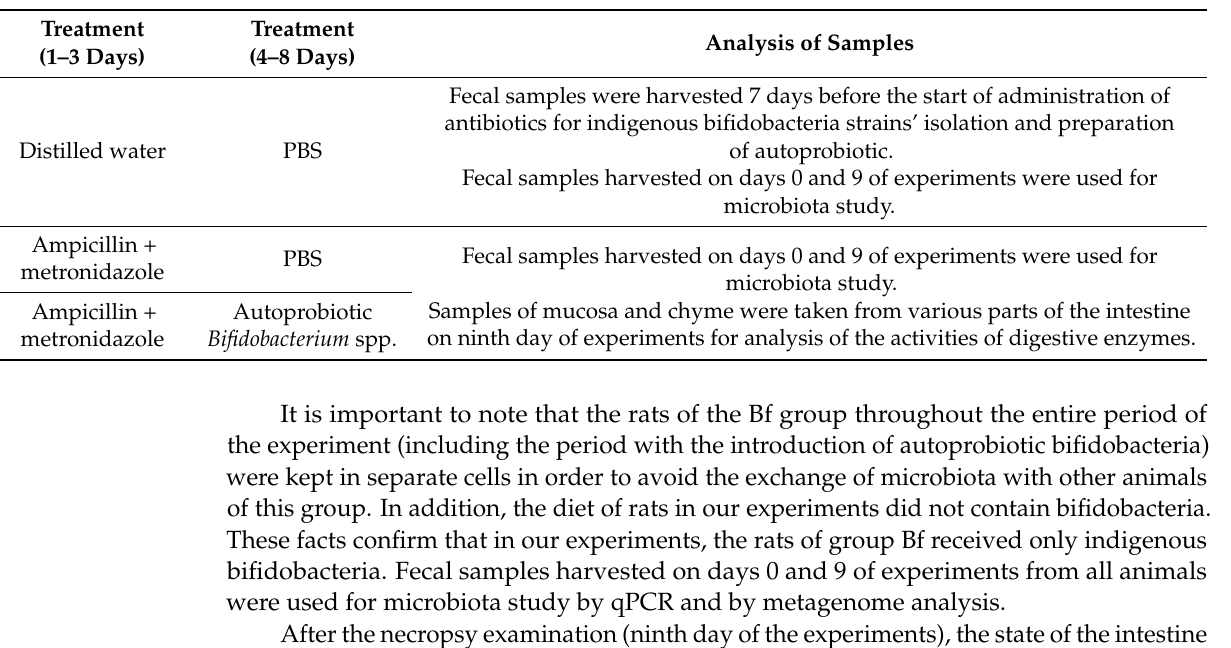
Table 2. Experimental